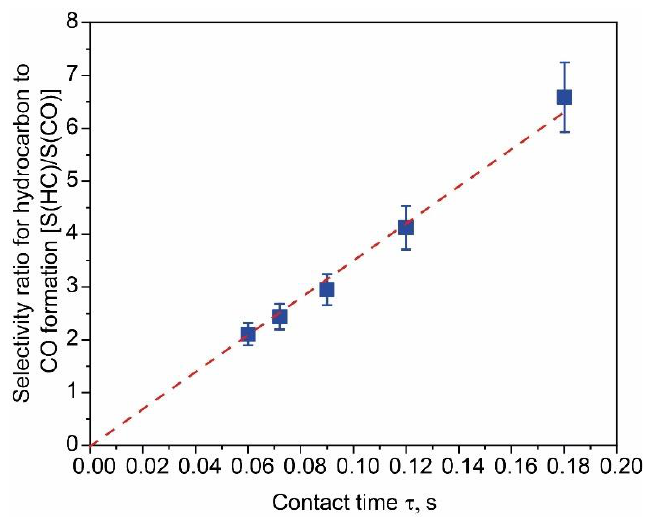
Figure 7. The ratio between HC and CO selectivity as a function of the contact